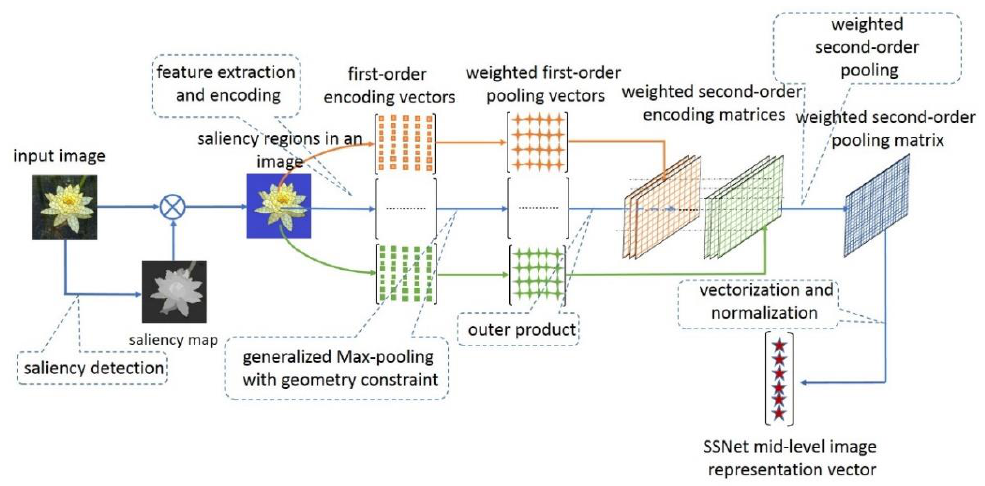
Figure 5. Illustration of the pipeline for generating the Salient Superpixel Network (SSNet) mid-level image